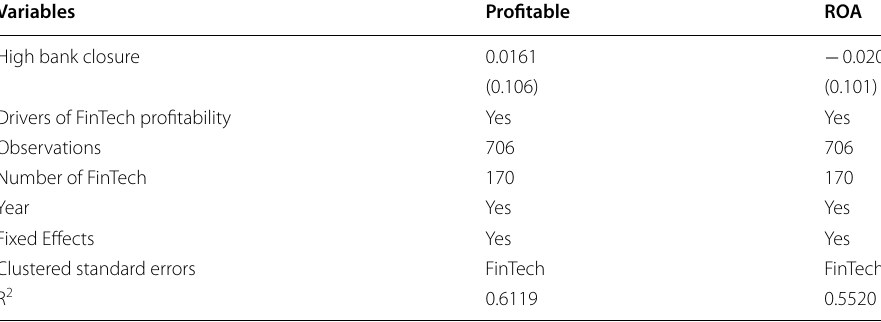
Table 13 The impact of bank restructuring